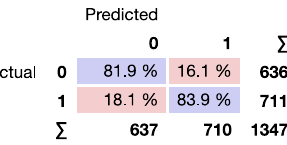
Fig. 3 Confusion matrix for MLP neural network. The confusion matrix measures classi fi er performance for models with dependent variables with two (0 and 1 in this fi gure) or more output values (classes). It depicts the percentage of correctly or incorrectly predicted classes in the